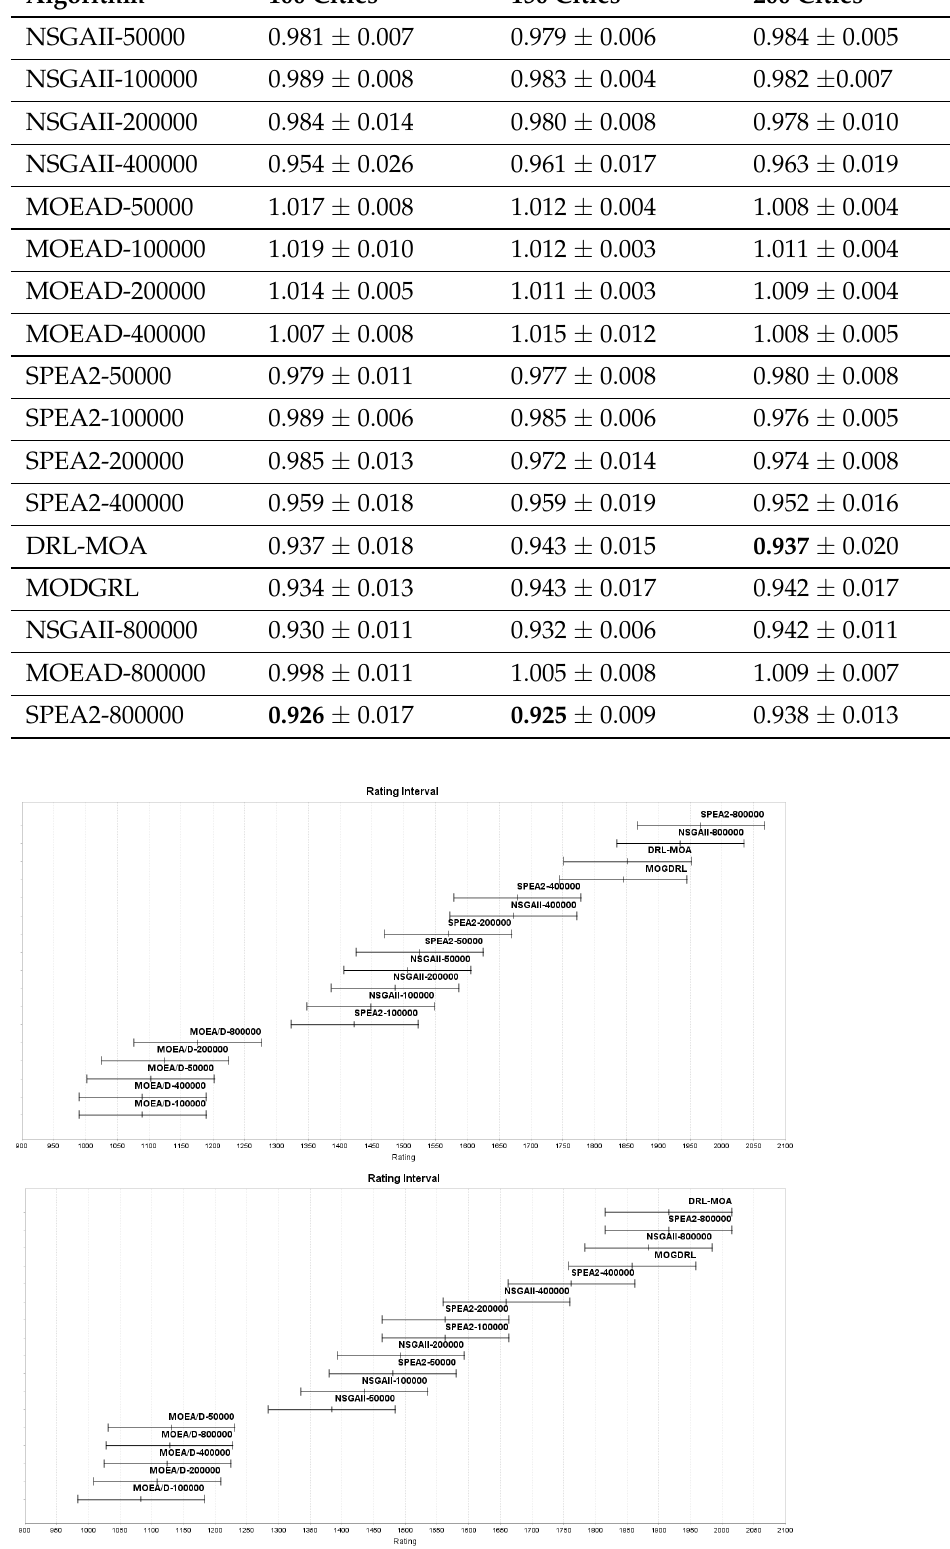
Figure A3. Spread ranking results for 150 cities (top row) and 200 cities (bottom